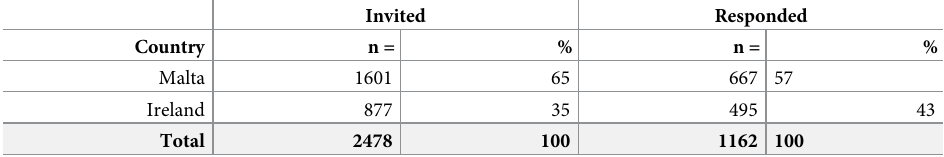
Table 1. Sample frame distribution of ERN survey respondents by country.